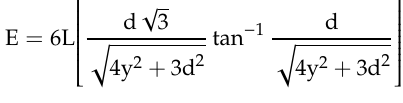
Figure A3. Configuration factor between a hexagon composed of 12 rotated triangles and a point under the center in a parallel plane. A.6. Circle Finally, the limiting case of all simple figures composed of triangles is a regular n → ∞ sided polygon (Figure A4) whose limit is obviously a circle and in it: E = L 2 ·